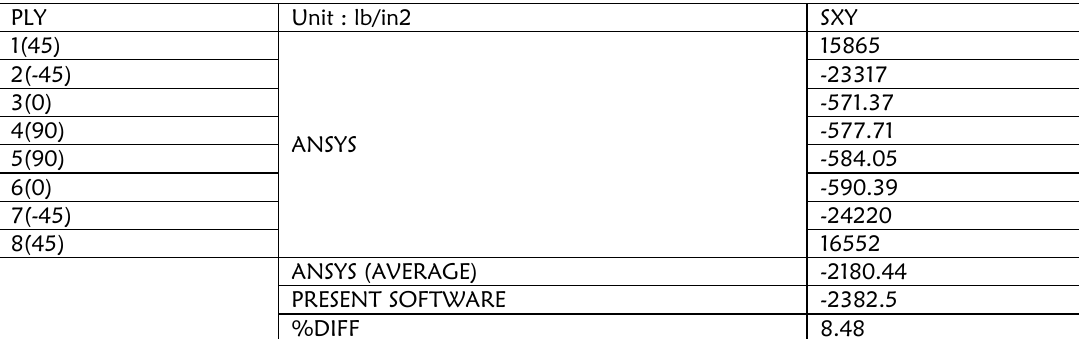
Table 8: Average shear stress on the upper flange of I-beam due to shear force